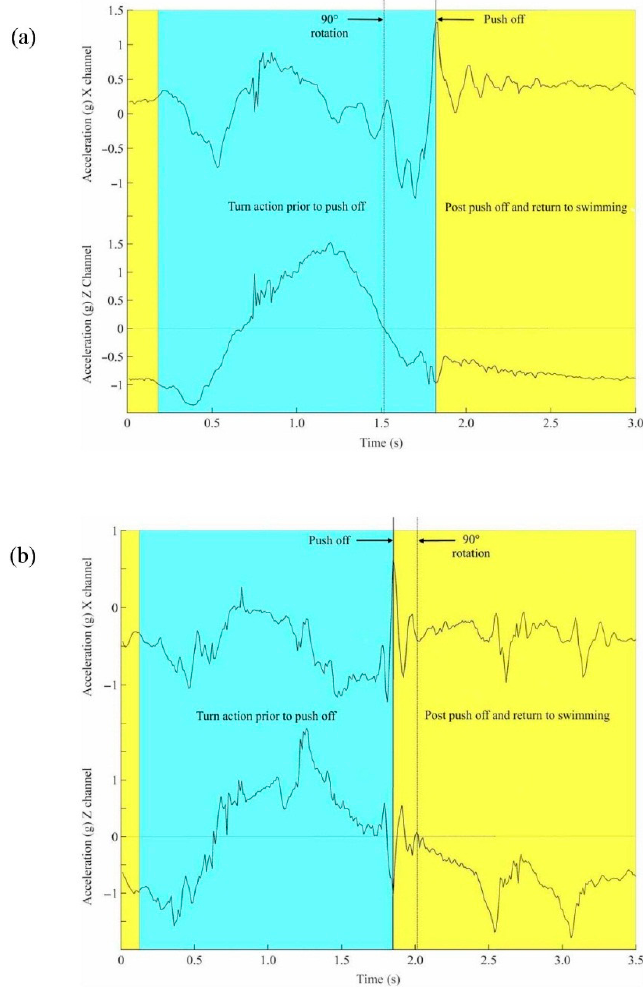
Figure 26. The analysis of swimming tumble turns is possible through examination of the acceleration signal. In this example, two swimmers rotation following the wall push off are compared. In ( a ), it can be seen that the swimmer has rotated by 1.57 rad (90°) before the wall push-off whilst in ( b ) the push-off occurs before the swimmer reaches 1.57 rad (90°) of rotation. Reproduced with permissions from Lee, Leadbetter, Ohgi, Theil, Burkett and James [56].